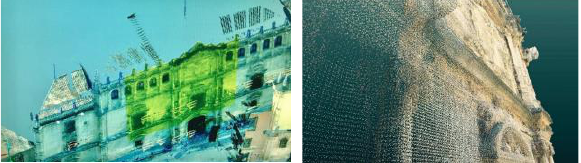
Figure 1: Façade University of Alcala. 3D scan by the Department of Architecture,